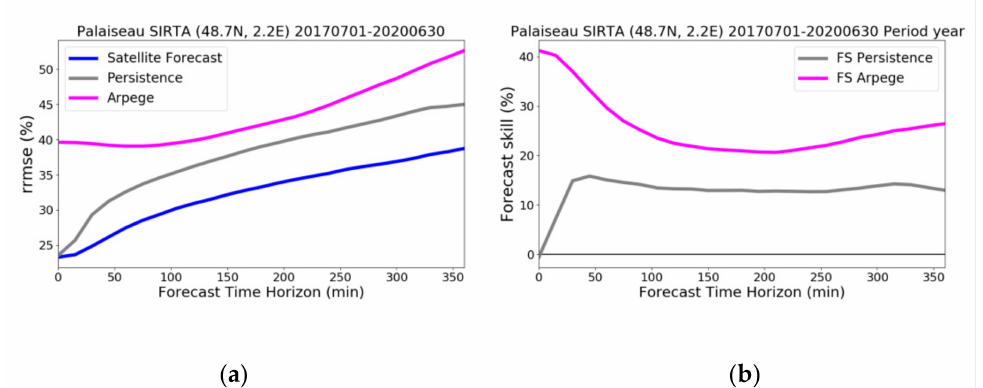
Figure 5. ( a ) Relative Root mean square error (RMSE) (%) as a function of time horizon for satellite-based forecast, persistence and ARPEGE. ( b ) Forecast skill (%) of satellite-based forecast against persistence and